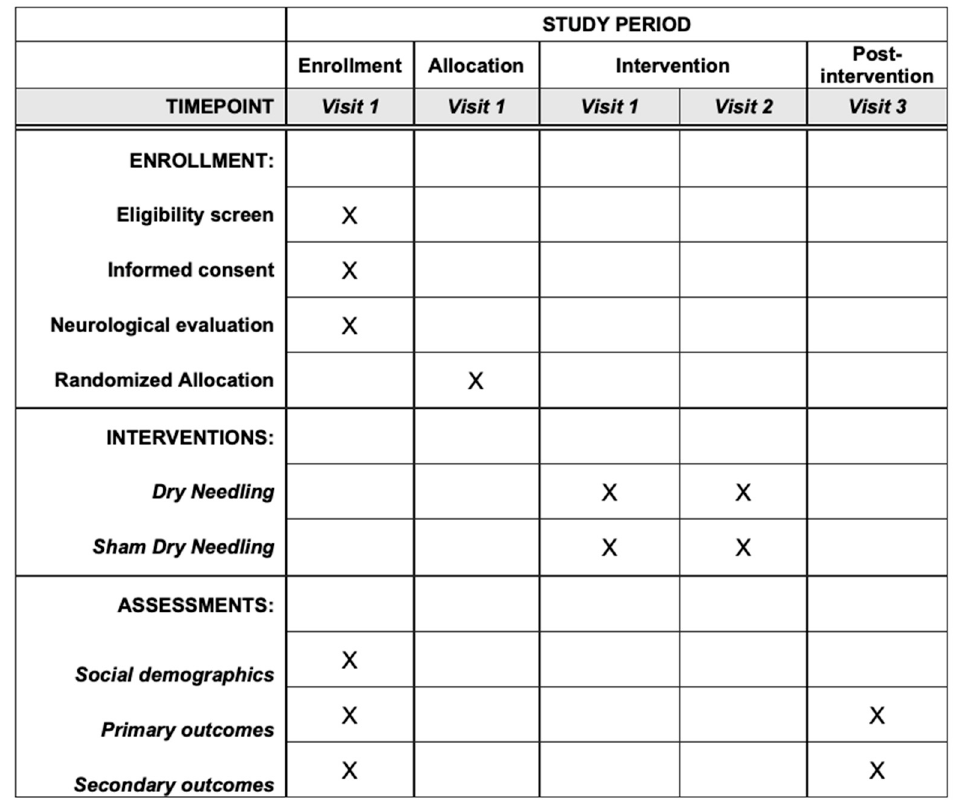
Figure 2. SPIRIT recommended content for the schedule of enrolment, interventions, and assessments.